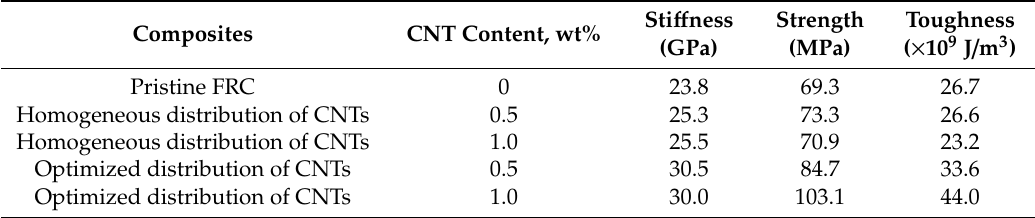
Figure 5. The effects of CNT-network morphologies on the mechanical properties of FRCs: ( a ) stress-strain curves of pristine FRC and the hierarchical FRCs with homogenous and optimized CNT distributions, strain energy consumptions in ( b ) pristine FRC, the hierarchal FRC with a content of ( c ) 0.5 wt% and ( d ) 1.0 wt%. Table 1. Comparisons of the e ff ective mechanical properties of the pristine FRC, the hierarchical FRCs with homogenously distributed CNTs and optimally positioned and oriented